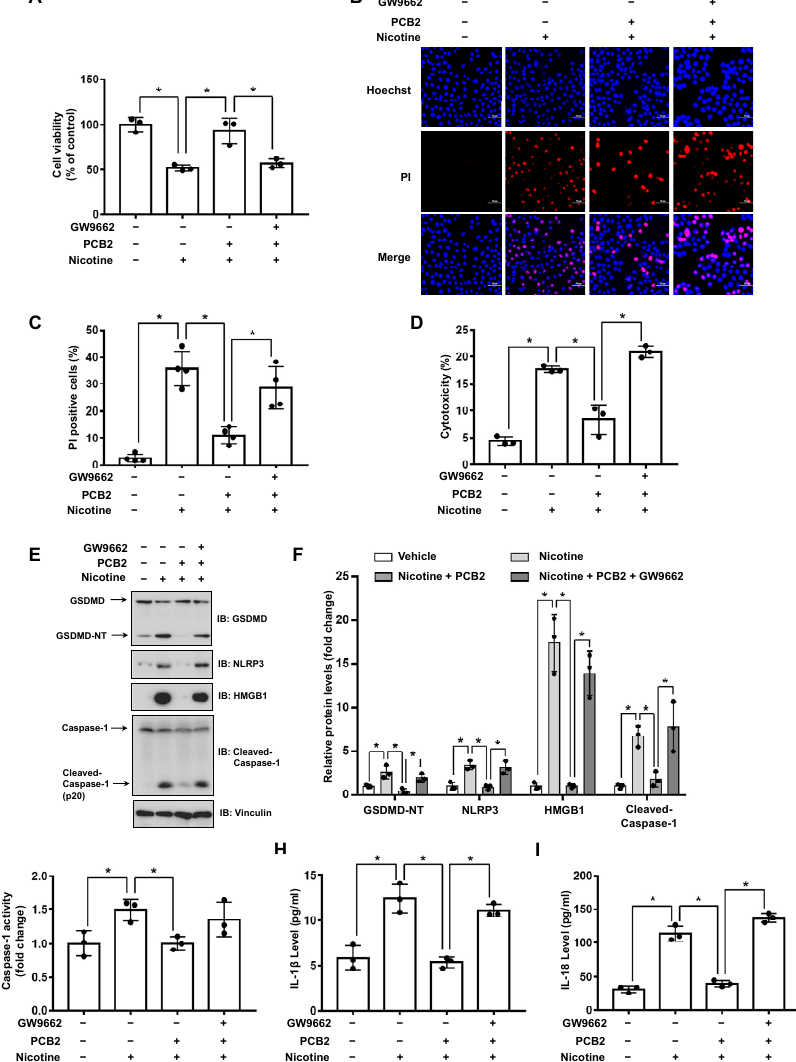
Figure 5. PCB2 prevents nicotine-induced pyroptosis through the activation of PPAR γ . LO2 cells were treated with or without 10 µ M GW9662 for 1 h followed by the treatment with 10 µ M PCB2 for 24 h. Cells were exposed to 100 µ M nicotine for 24 h before harvesting. ( A ) Cell viability was detected by CCK-8 assay following exposure to nicotine ( n = 3). ( B , C ) Hoechst 33342/PI staining, fluorescence imaging ( B ) was acquired by confocal microscopy. Scale bar: 50 µ m. The percentage of PI-positive cells ( C ) was analyzed by using ImageJ software ( n = 4). ( D ) Cytotoxicity was determined by LDH release assay following exposure to nicotine ( n = 3). ( E ) The proteins levels of GSDMD, NLRP3, HMGB1 and Cleaved-Caspase-1 by using immunoblotting. ( F ) Quantification of GSDMD-NT, NLRP3, HMGB1 and Cleaved-Caspase-1 levels as in ( E ) ( n = 3). ( G ) The activity of Caspase-1 was determined by using Caspase-1 activity assay kit ( n = 3). ( H , I ) The concentrations of IL-1 β ( H ) and IL-18 ( I ) in the conditioned medium were determined by ELISA ( n = 3). Data shown represent the mean ± SD (*, p <